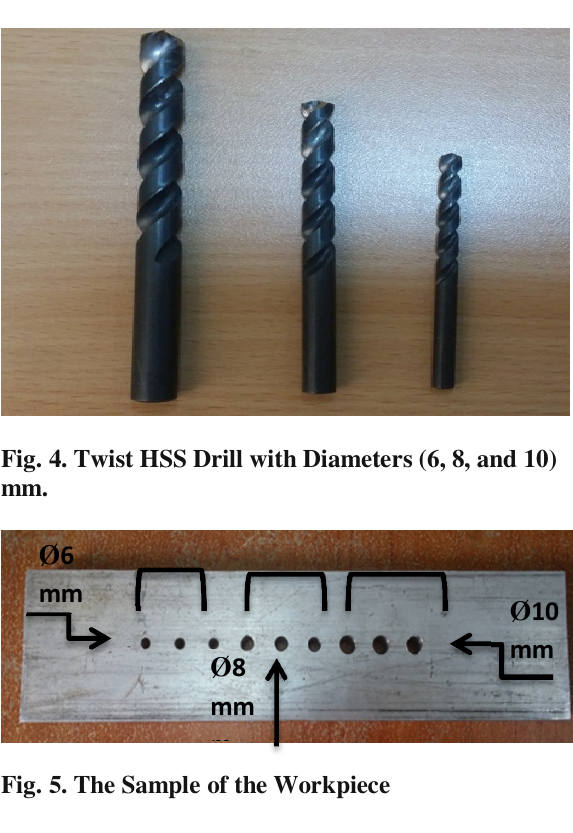
3.4 Analysis of “Signal -To –Noise” Ratio Taguchi approach used Signal To Noise (S/N) ratio to calculate the variance of the experimental design. The equation of (Smaller-the-Better) was chosen to calculate the (S/N) ratio, because the smallest value of surface roughness is required to get a good product quality. Table (5) shows the ) and (S/N) ratio of result of surface roughness (R a the surface roughness.